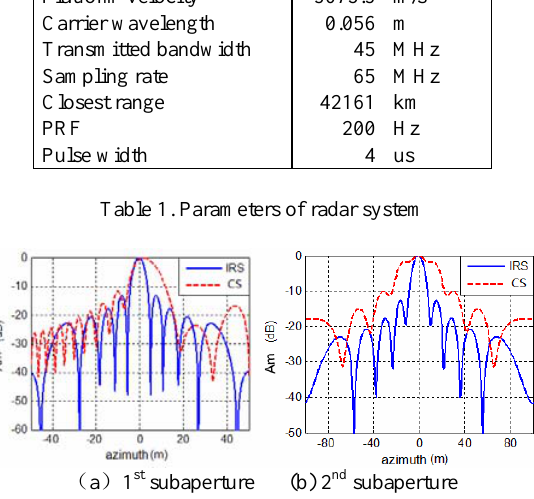
Figure 7.Azimuth Point Impulse responses between subaperture focusing algorithm and traditional CS algorithm